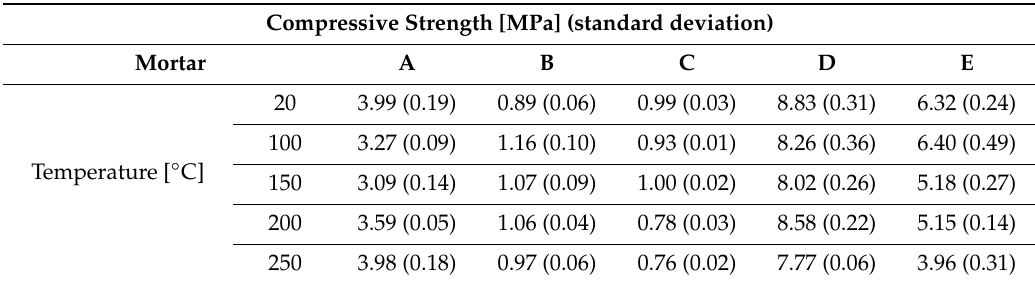
Table 6. Compressive strength average vs. exposure